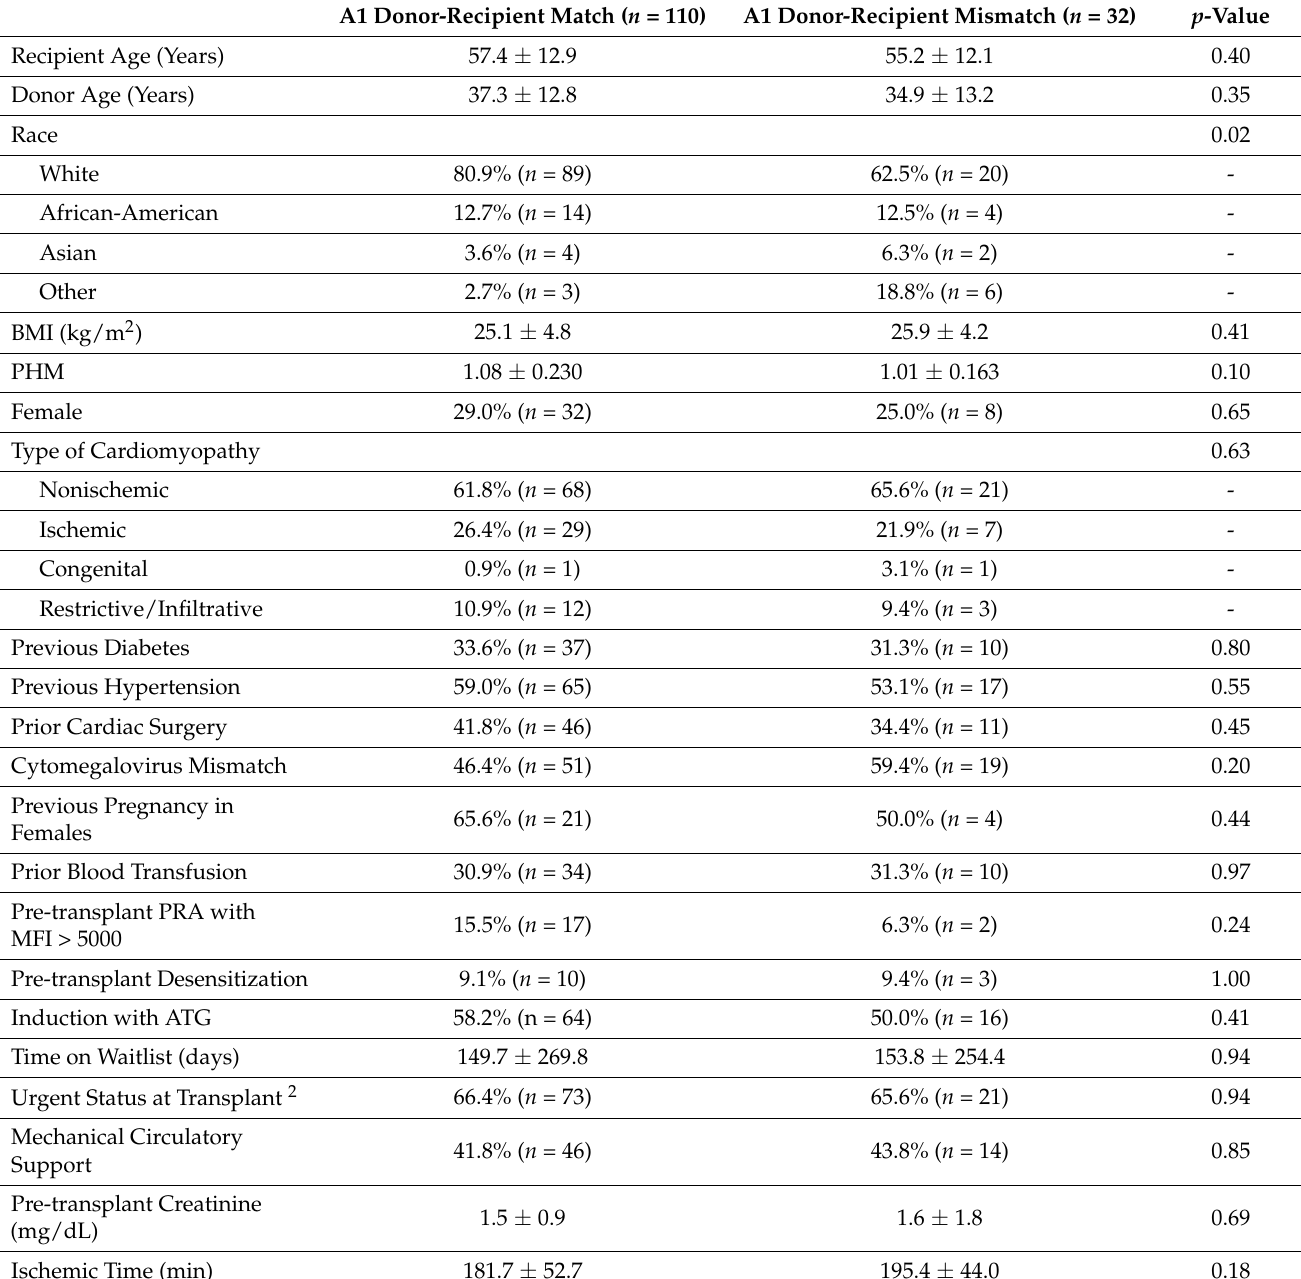
Table 1. Pre-Transplant Clinical Characteristics 1